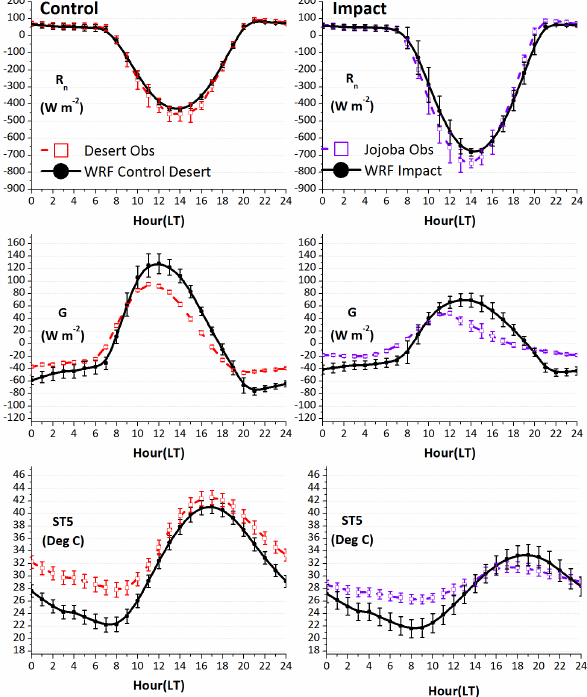
Fig. 9. Validation of WRF Control and Impact with observations for mean summer diurnal cycles of net surface radiation ( R n ), ground flux ( G ) and 5cm soil temperatures